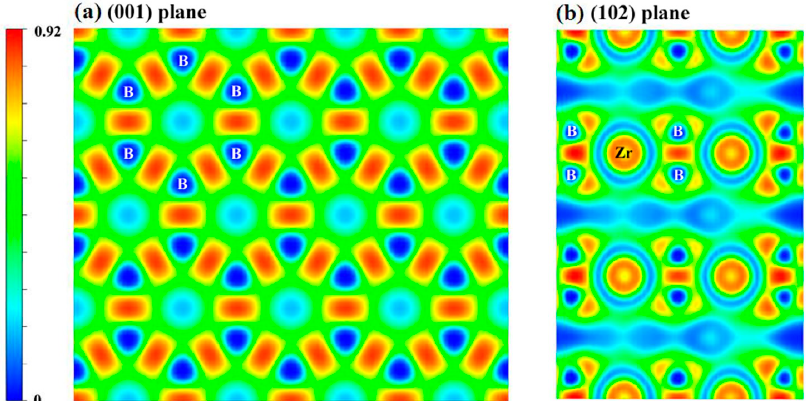
Figure 7. Total and partial density of states of the C 2/ m -ZrB 3 : ( a ) 0 GPa; ( b ) 20 GPa; ( c ) 50 GPa; and ( d ) 100 GPa. The vertical dashed line denotes the Fermi level E F .